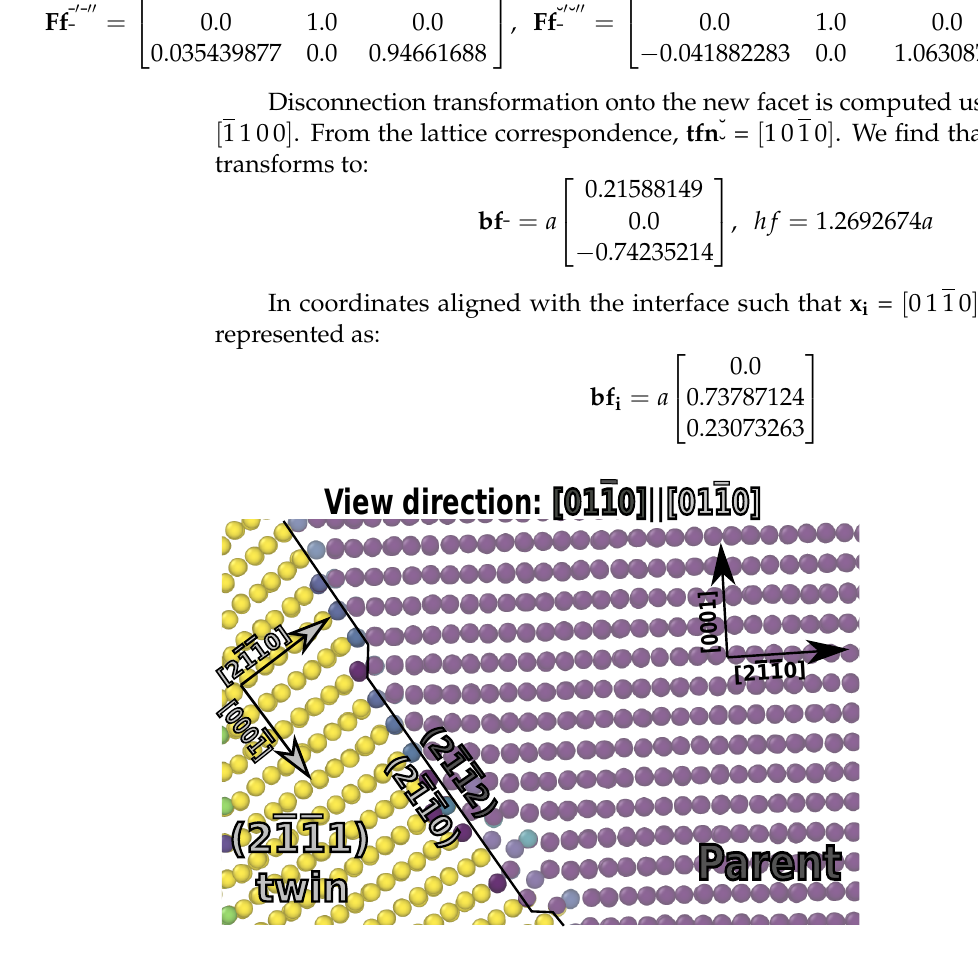
Figure 6. ( 2111 ) twin facet onto ( 2112 ) || ( 2110 ) . A one layer step is visible in the